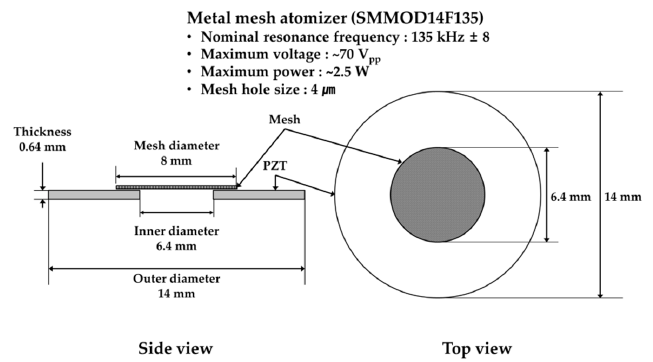
Figure 2. Piezoelectric ceramic (PZT) and metal mesh module dimension.